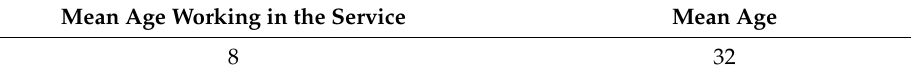
Table 2. Mean age in service and